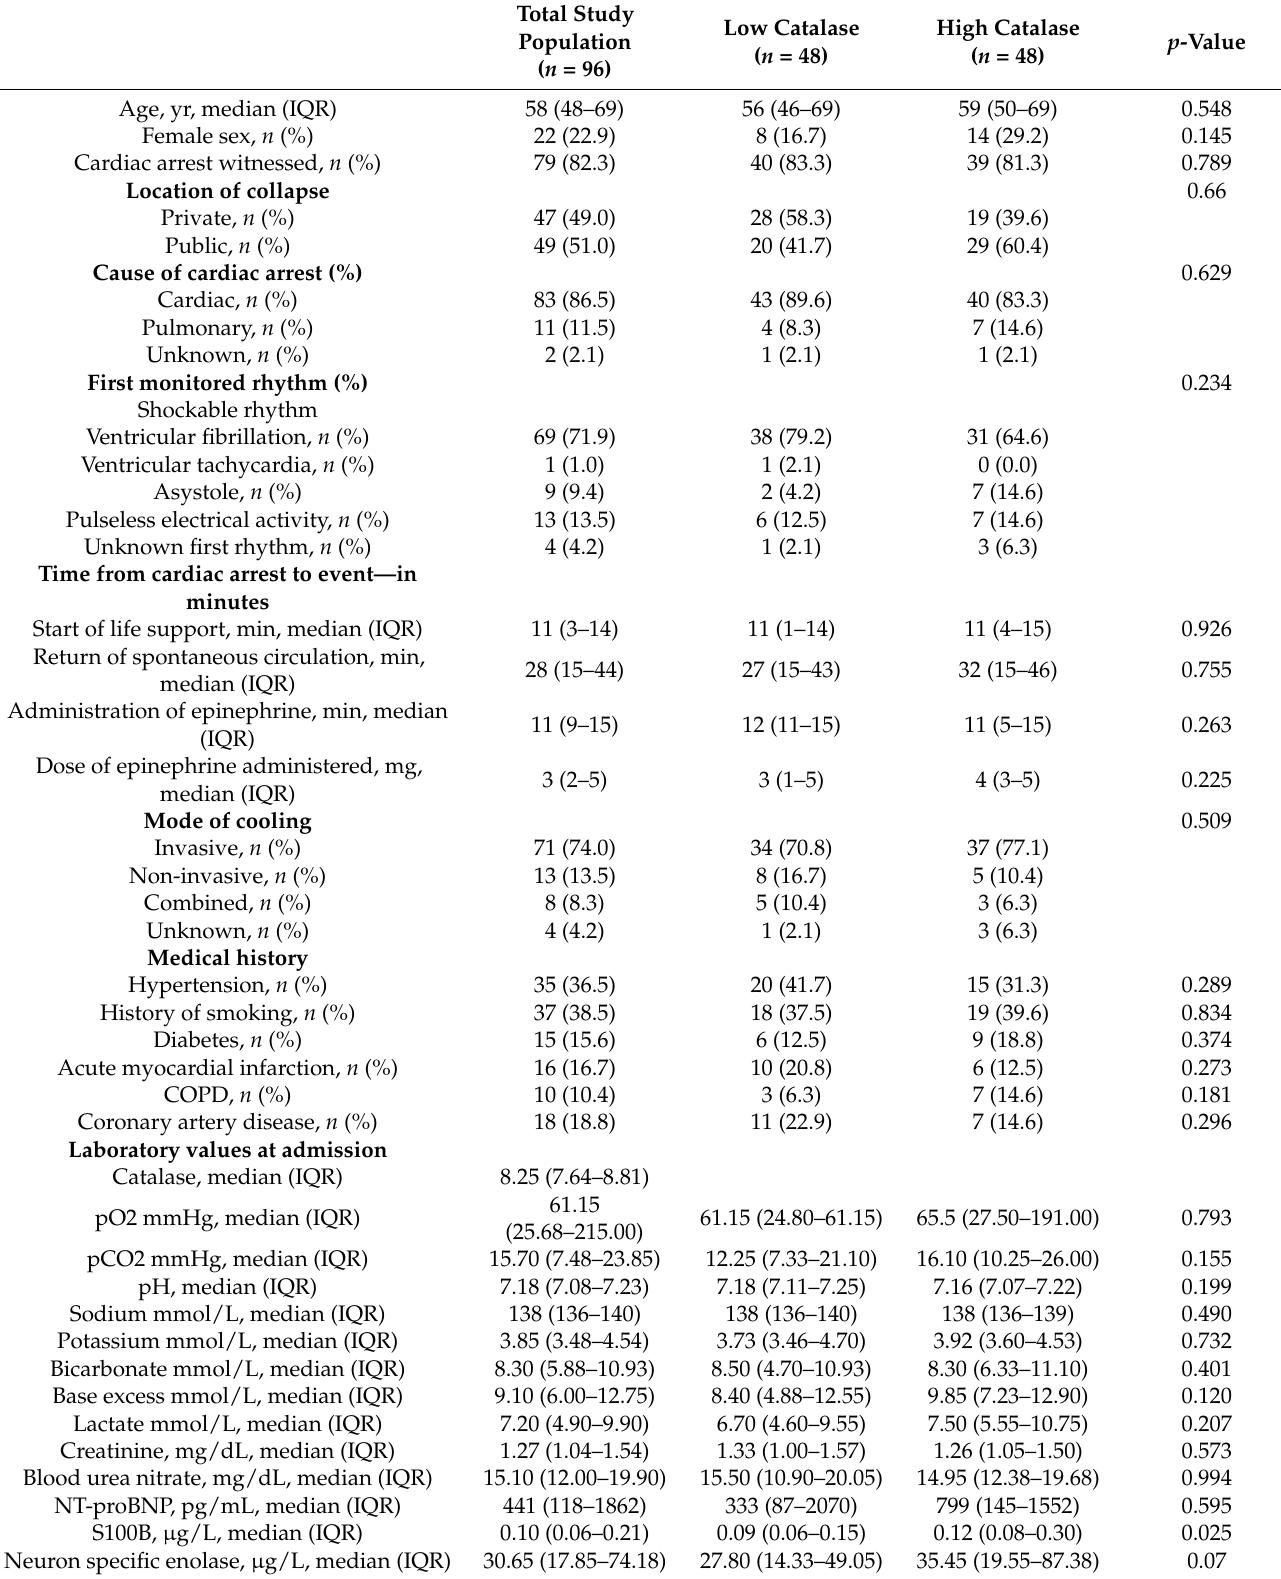
Table 2. Patient baseline characteristics of total study population ( n = 96), and for patients with low (<8.25) and high ( ≥ 8.25) catalase abundance values (Log 2 ), measured with multiple reaction monitoring